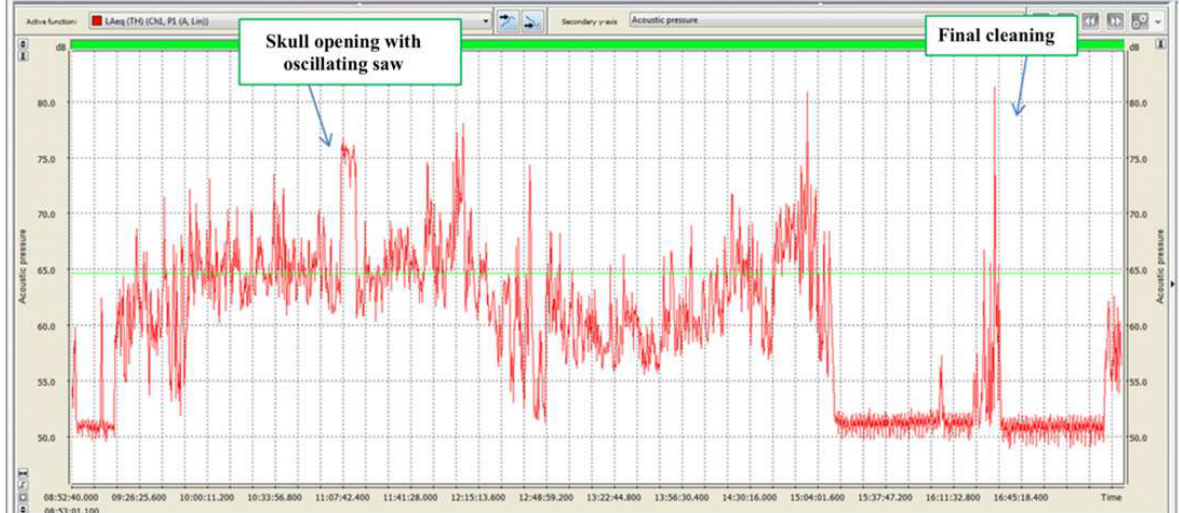
Figure 3. 30.09.2016. Acoustic emissions during 3 autopsies, each one performed on a different dissection table. Red line: equivalent sound level during T period of 15” (Leg), expressed as dB (A). Green line: equivalent sound level during the entire monitoring period (Leg), expressed as dB (A).